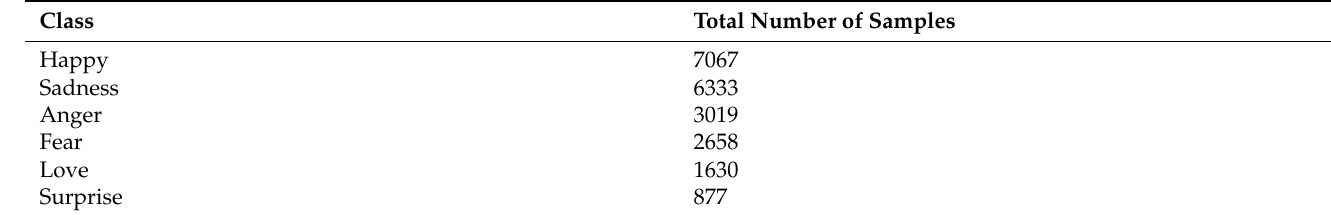
Table 5. Distribution of samples in the Emotion Training Dataset.